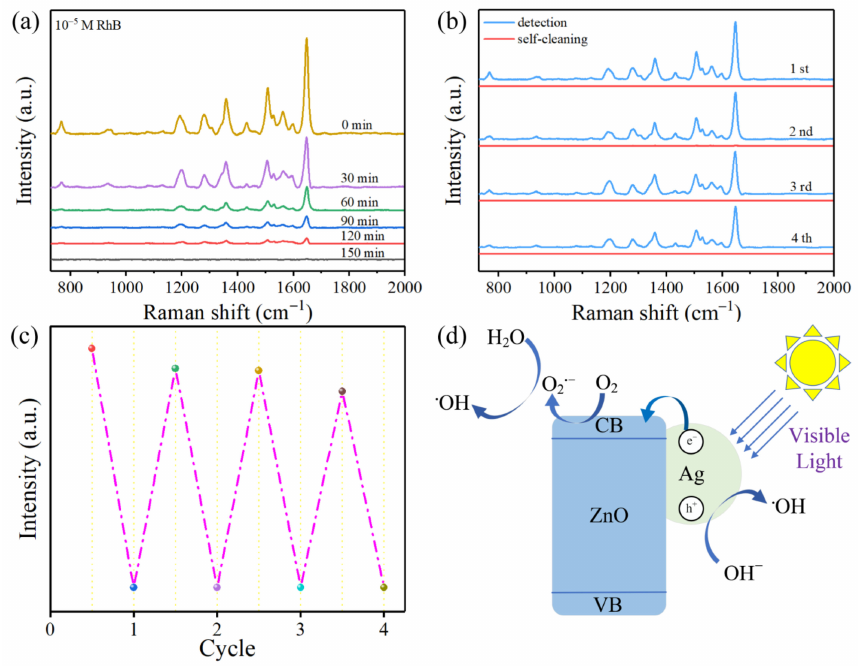
Figure 10. ( a ) SERS spectra of the degradation of 10 − 5 M RhB. ( b ) SERS spectra of 10 − 5 M RhB before and after the self-cleaning test. ( c ) Raman intensity at 1648 cm − 1 in 4-cycle detection of 10 − 5 M RhB on the substrate. ( d ) Schematic diagram of the photocatalytic